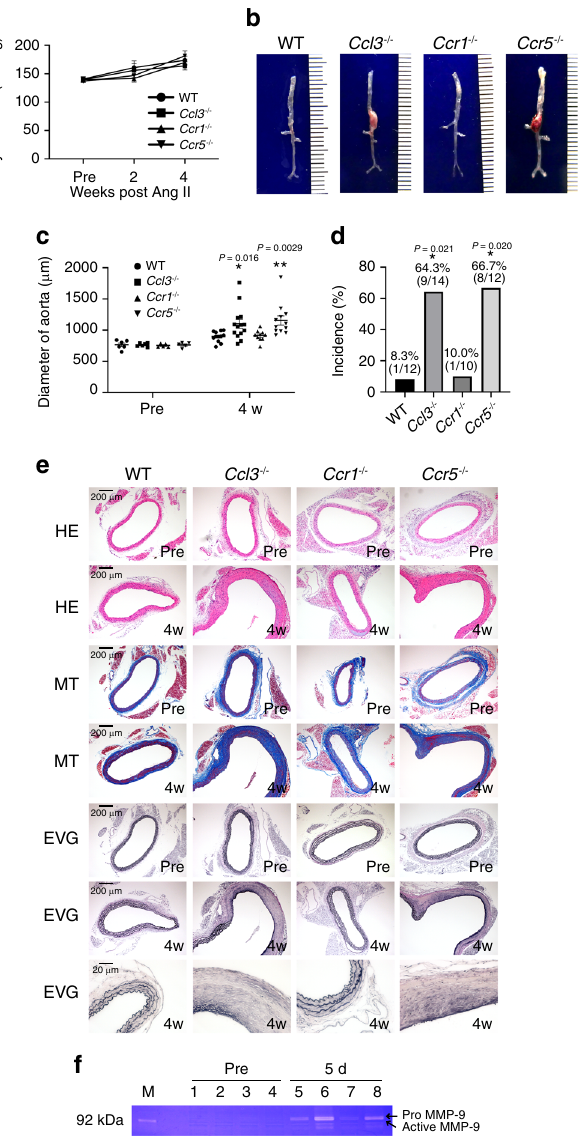
Fig. 9 The roles of the CCL3 – CCR5 axis on Ang II-induced AAA formation. a Systolic blood pressure at the indicate time points after Ang II infusion (Pre: n = 7 in each mouse strain; 2 week: n = 9 in WT mice, n = 4 each in Ccl3 − / − and Ccr1 − / − , n = 5 in Ccr5 − / − mice; 4 week: n = 4 each in WT, Ccr1 − / − , and Ccr5 − / − mice, n = 5 in Ccl3 − / − mice). b Representative macroscopic appearance of the aorta in each mouse strain after Ang II infusion. c The diameters of the aorta in mice at 4 weeks after Ang II infusion (Pre: n = 6 each in WT and Ccl3 − / − mice, n = 5 each in Ccr1 − / − and Ccr5 − / − mice; 4 week: n = 12 each in WT and Ccr5 − / − mice, n = 14 in Ccl3 − / − mice, n = 10 in Ccr1 − / − mice). ** P < 0.01, * P < 0.05, vs. posttreatment in WT mice. d Incidence of AAA in WT, Ccl3 − / − , Ccr1 − / − , and Ccr5 − / − mice after Ang II infusion. * P < 0.05, vs. WT. e Histopathological analysis of the aortas obtained from WT, Ccl3 − / − , Ccr1 − / − , and Ccr5 − / − mice after Ang II application . f Intra-aortic MMP-9 activities were measured by gelatin zymography on day 5 after Ang II infusion. M molecular weight marker. 1 and 5, WT; 2 and 6, Ccl3 − / − ; 3 and 7, Ccr1 − / − ; 4 and 8, Ccr5 − / − . Independent experiments were repeated four times. Unpaired two-sided Student ’ s t test was used in ( a ) Steel – Dwass ’ s multiple comparison test was used in ( d ). Data are presented as mean values ±